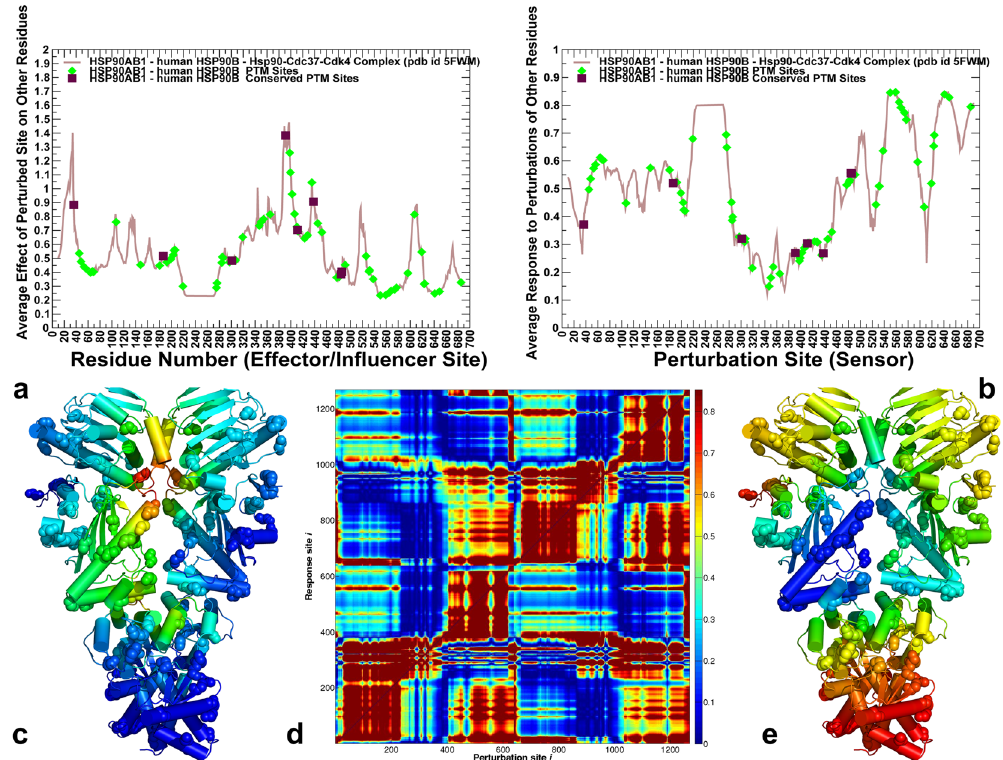
Figure 8. The PRS Analysis of the human Hsp90 β Identifies Effector and Sensor Sites of Allosteric Signaling. ( a ) The residue-based effector profile measures the average impact of the perturbed site on all other residues in the human Hsp90 β dimer structure. The effector profile value for a given residue is the average over all elements of the PRS matrix in the corresponding row. ( b ) The residue-based sensor profile measures the average response of a given residue to perturbations of all other residues in the human Hsp90 β dimer. The sensor profile value for a given residue is the average over all elements of the PRS matrix in the corresponding column. In panels (a,b) the effector/sensor parameter values for PTM sites are highlighted as green filled diamonds, and for conserved PTM sites in filled maroon squares. ( c ) The crystal structure is color-coded by ability to propagate perturbations, where red regions are strongest effectors. ( d ) The normalized PRS heat map where the strongest signals of high sensor/effector residues are shown in dark red. ( e ) The crystal structure of the human Hsp90 β is color-coded by sensitivity to perturbation. Red/orange regions are the most susceptible sites, called sensors, while dark-blue regions are the most insensitive sites; green/cyan regions show moderate sensitivity to